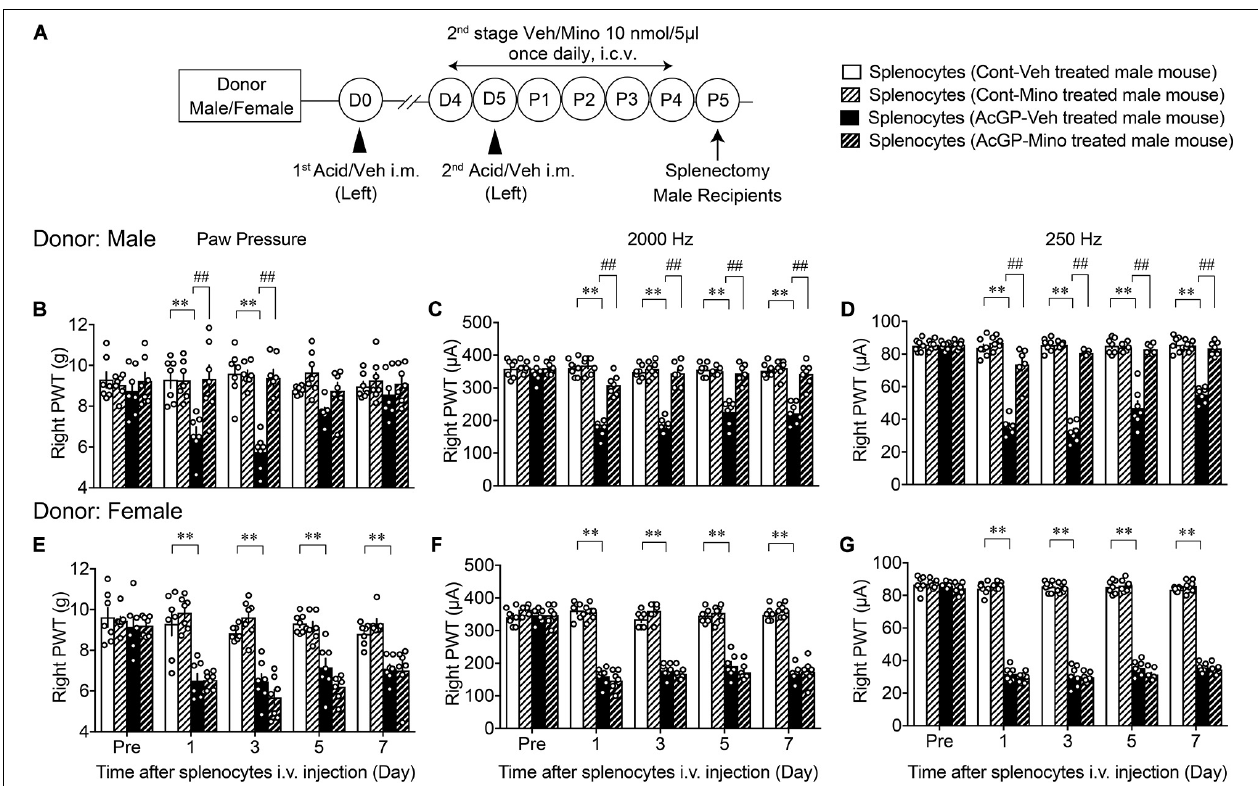
FIGURE 6 | Allodynia by splenocytes derived from mice with AcGP and its blockade by brain minocycline pretreatments in male mice. (A) Experimental design. (B–G) Allodynia by i.v. injection of splenocytes from male and female mice with AcGP with or without minocycline treatments. Splenocytes prepared from male (B–D) or female (E–G) mice with control or acid saline injection (left) were i.v. injected into naive male mice. Paw pressure and EPW tests were performed on the right side after the splenocyte injection. The 2nd stage of vehicle or minocycline treatments was given to donor male or female mice. ∗∗ p < 0.01, compared with Pre Veh, in two-way repeated measures ANOVA followed by Dunnett’s multiple comparisons test. ## p < 0.01, compared with each time point at splenocytes (AcGP-Veh-treated mouse), in two-way repeated measurement ANOVA followed by Tukey’s multiple comparisons test ( n = 7). The dots in the column represent number of animals. AcGP, acid saline-induced FM-like generalized pain; PWT, paw withdrawal